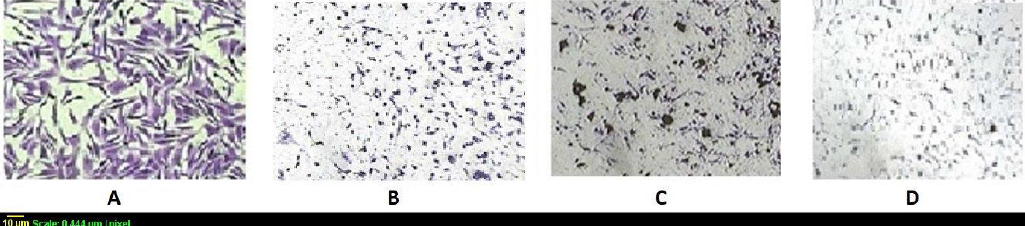
Figure 4. Morphological changes induced in the HepG2 cells by the LVS-ZN NPs. ( A ) Control, ( B ) raw LVS, ( C ) ZN, and ( D ) LVS-ZN NPs.